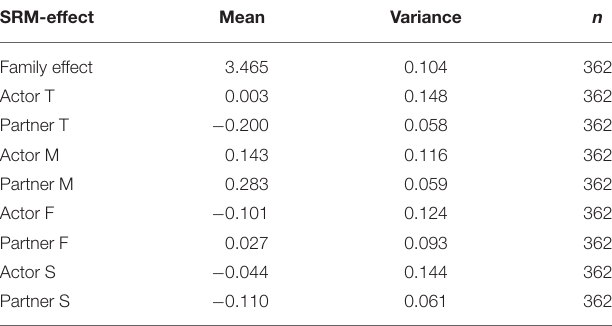
TABLE 2 | Means, variances, and number of observations of the ANOVA